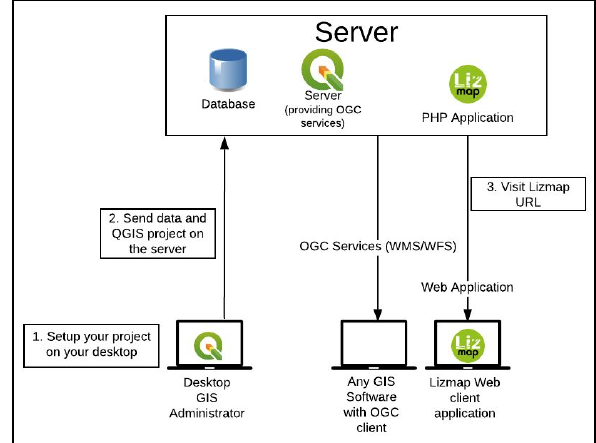
Figure 7 : Lizmap Architecture (Lizmap Documentation,